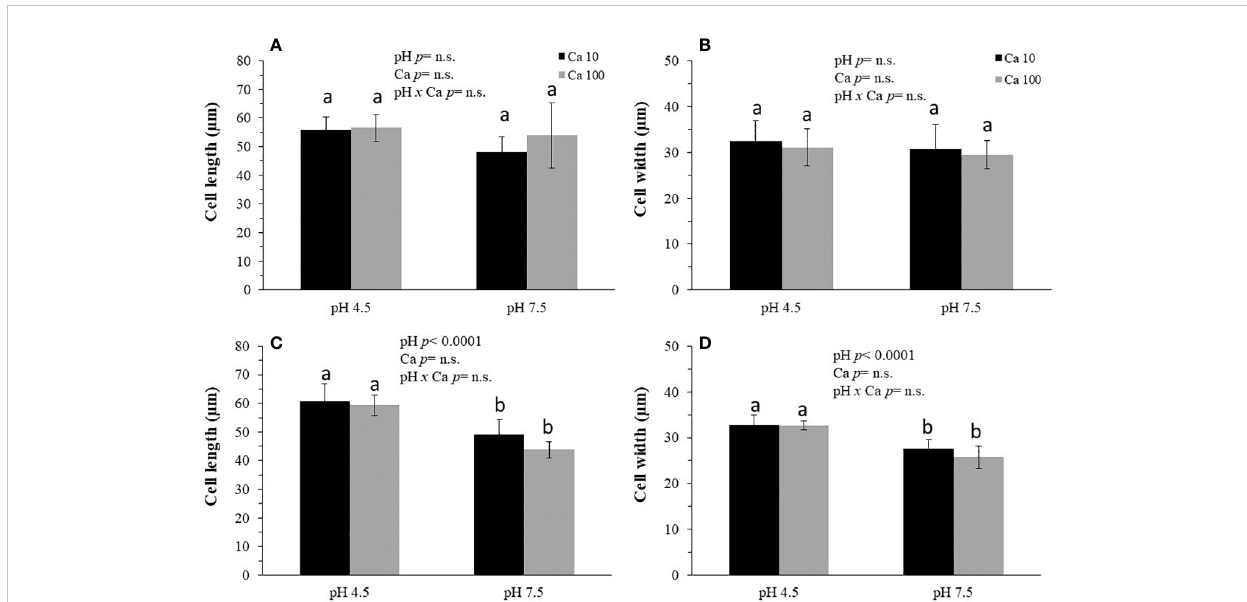
FIGURE 1 The effects of pH and Ca concentration on epidermal cell-wall length (A, C) and width (B, D) in blueberry roots. Southern highbush blueberry plants ( Vaccinium corymbosum , cv. Windsor) were cultured for 1 (A, B) or 3 (C, D) days in nutrient solutions of pH 4.5 or 7.5 that contained 10 or 100 mg L -1 Ca. Means in the sub- fi gures followed by different letters (a, b) are different according to LSMeans Student's t test. One cm of the root tip was stained with Calco fl uor white and root epidermal cells were sampled at a distance of 500 m m from the root tip to determine the length and width of root epidermal cells. Data are means ± SD ( n = 3). All data were subjected to a three-way analysis of variance